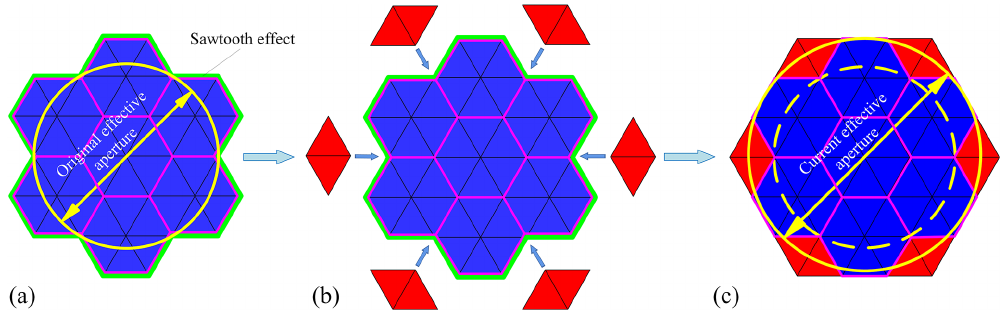
Figure 2. Comparison of the effective aperture of a single configuration and multiple configuration. (a) Single configuration. (b) Multicon- figurational combination. (c) Multiconfigurational